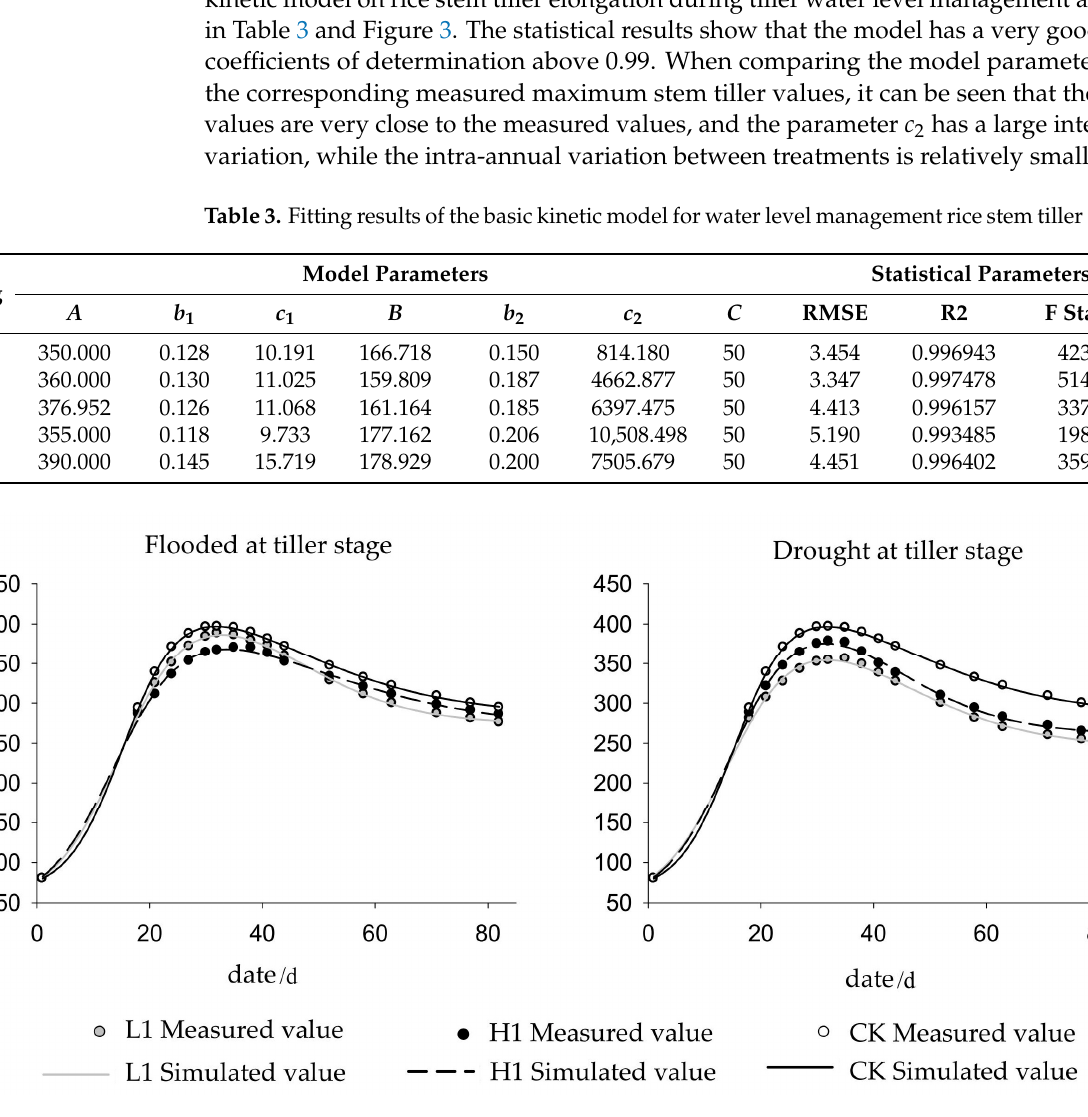
Figure 3. Fitted stem tiller elongation curve for rice under water level management at the tiller stage.